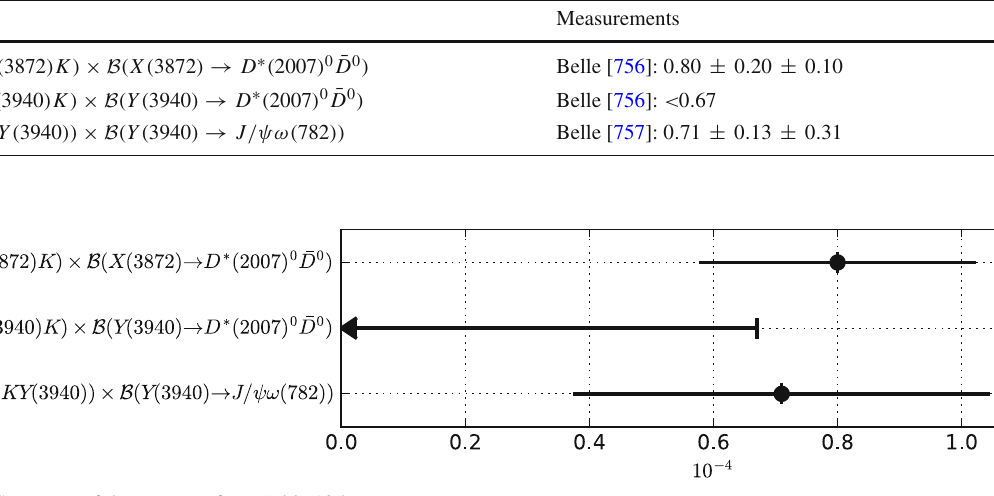
Fig. 151 Summary of the averages from Table 185 Table 186 Decays to a D Parameter